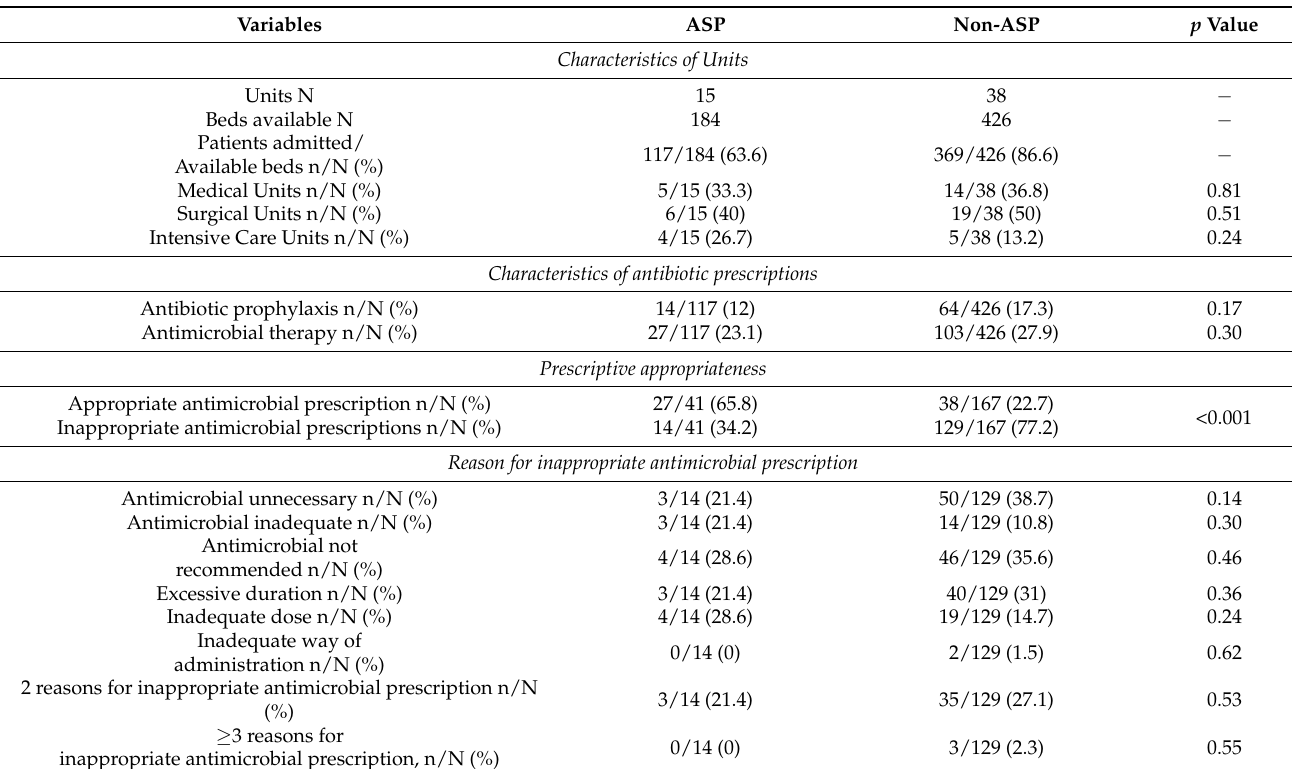
Table 1. Characteristics and global adequacy of antimicrobial prescription between ASP and non-ASP units. Variables ASP Non-ASP p Value Characteristics of